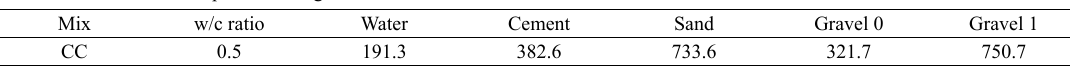
Table 2. Concrete Mix Proportions in kg/m 3